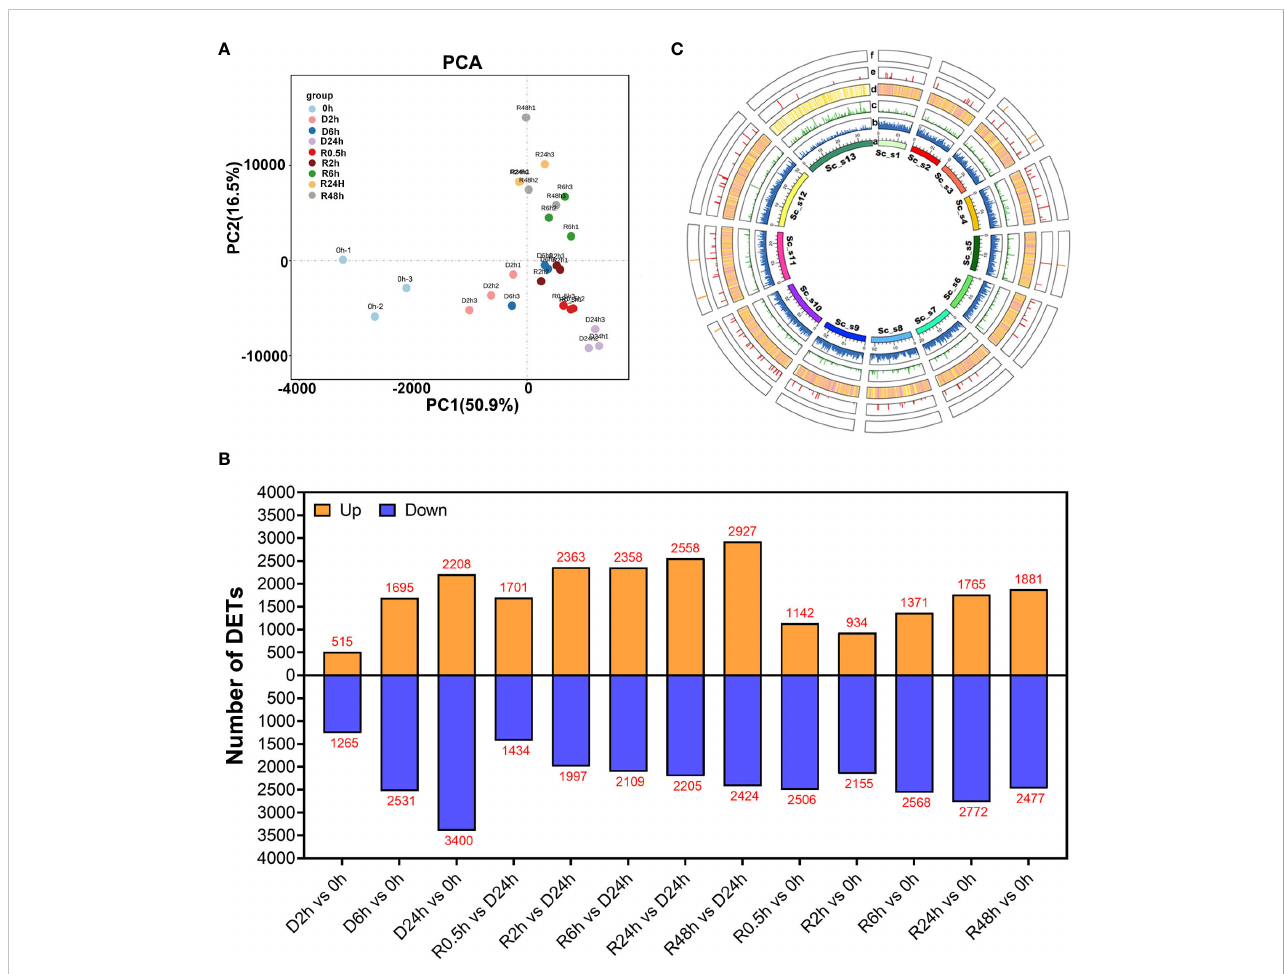
FIGURE 2 PCA, Circos, DETs of S. caninervis transcriptome during D-R treatment (A) PCA of RNA-Seq data obtained from S. caninervis of full hydrated (0 h), dehydrated (D h) and rehydrated (R h) gametophyte. (C) Circos visualization of genomic and transcriptomic features of S. caninervis under D-R process. a: Chromosomes; b: Gene distribution density, and the height of the column represents the number of genes at the within unit region; c: Novel transcripts distributions from transcriptome, the green column and length show its density mapping on chromosome; d: Transcript density distribution, the heatmap represent transcript density with white (min), yellow (middle) and red (max); e and f: Alternative splice position, the column of red and yellow represent SE and ME, the column of length represent their number of occurrences; (B) Number of DETs among different comparison pairs. |Log 2 (Fold Change)| ≥ 1 and p -value ≤ 0.05 were used as the threshold to select